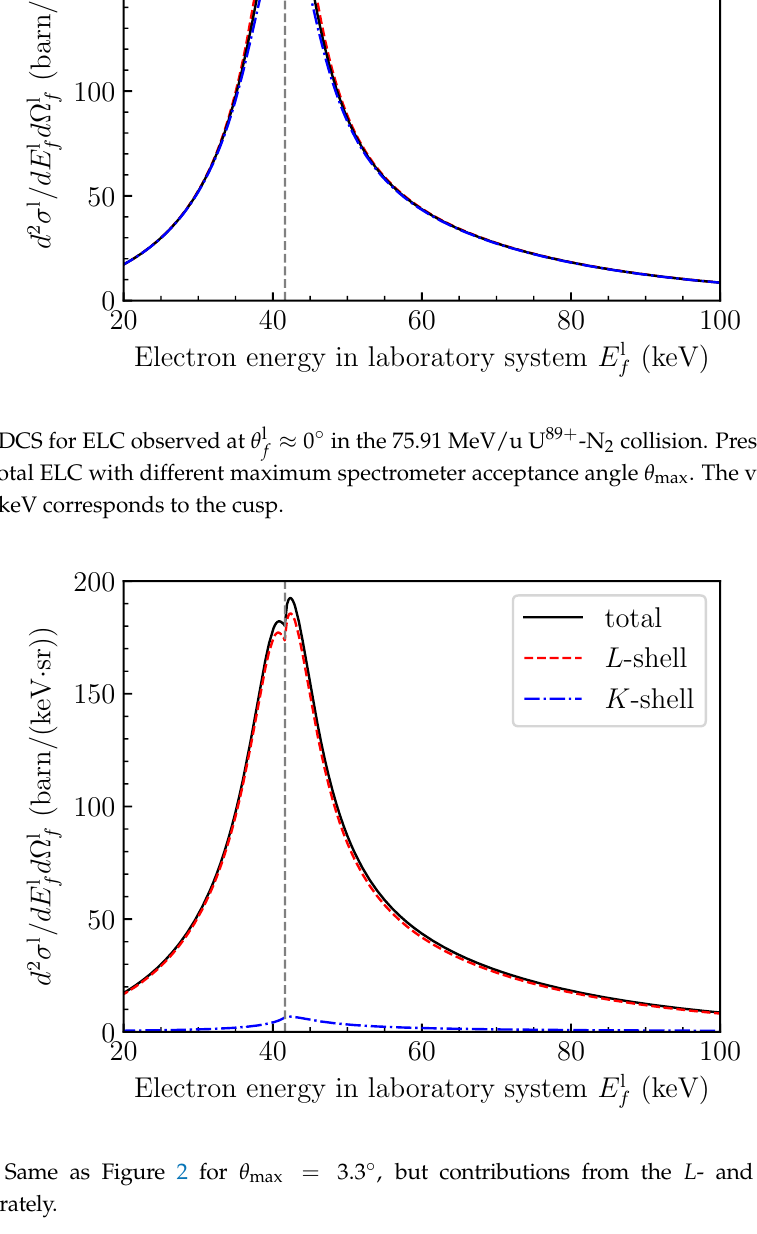
Figure 3. Same as Figure 2 for θ max = 3.3 ◦ , but contributions from the L - and K -shells are shown